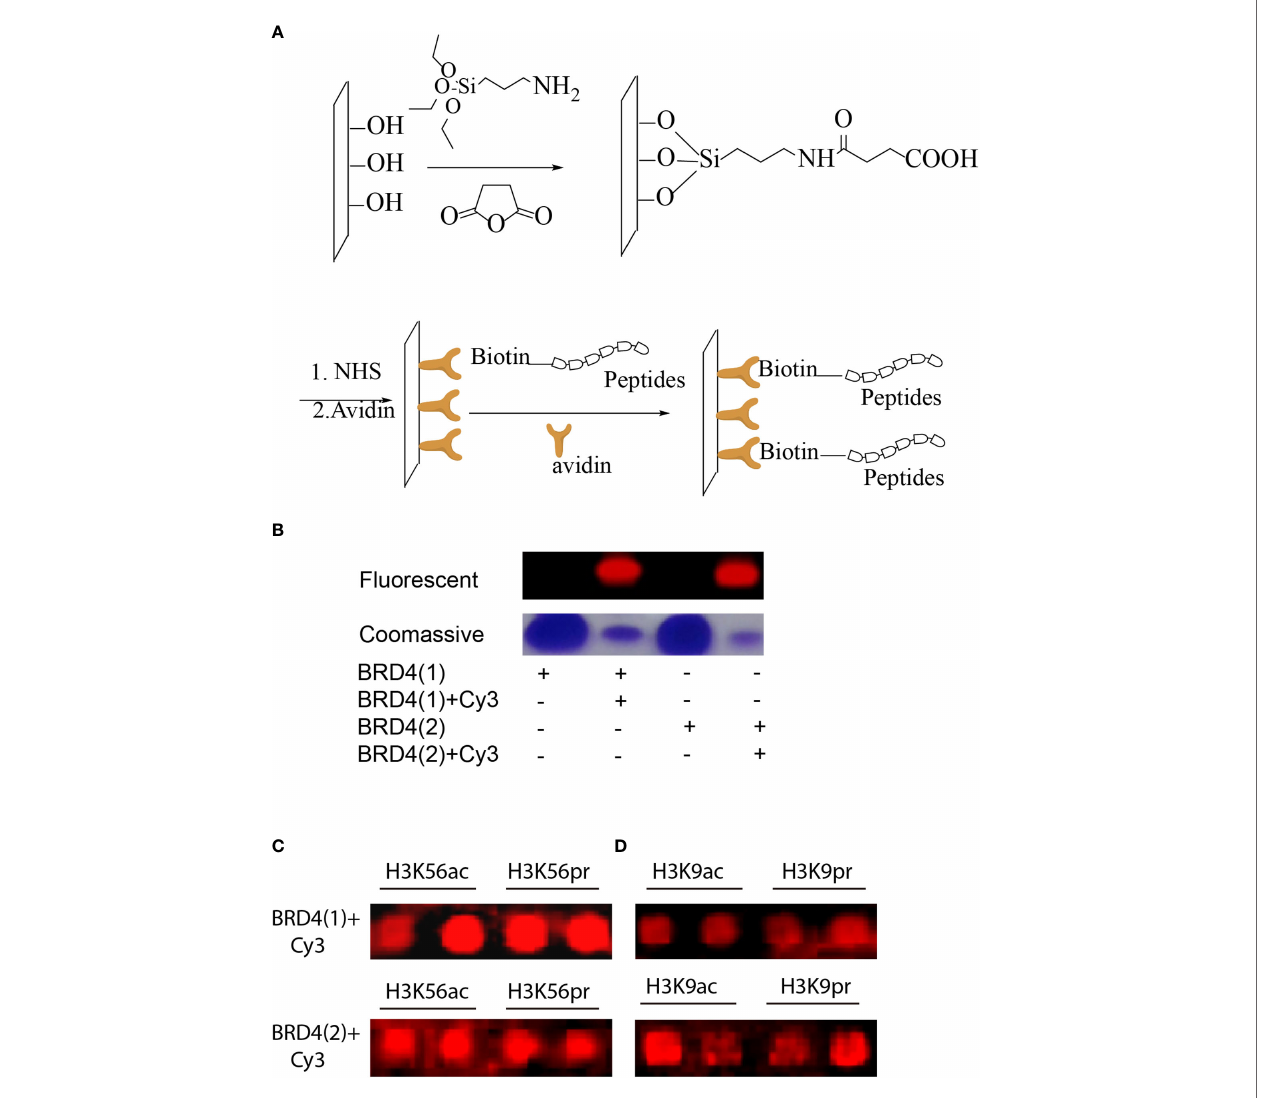
FIGURE 3 | (A) Peptides with N-terminal biotin immobilized on avidin-functionalized slides. (B) Fluorescent and Coomassie gel images of representative fl uorescent- labeled bromodomains (BRDs). (C) Microarray images of fl uorescent-labeled BRD4 (1) binding to a small peptide library based on H3K56 or H3K9 modi fi cations. (D) Microarray images of fl uorescent-labeled BRD4 (2) binding to a small peptide library based on H3K56 or H3K9 modi fi